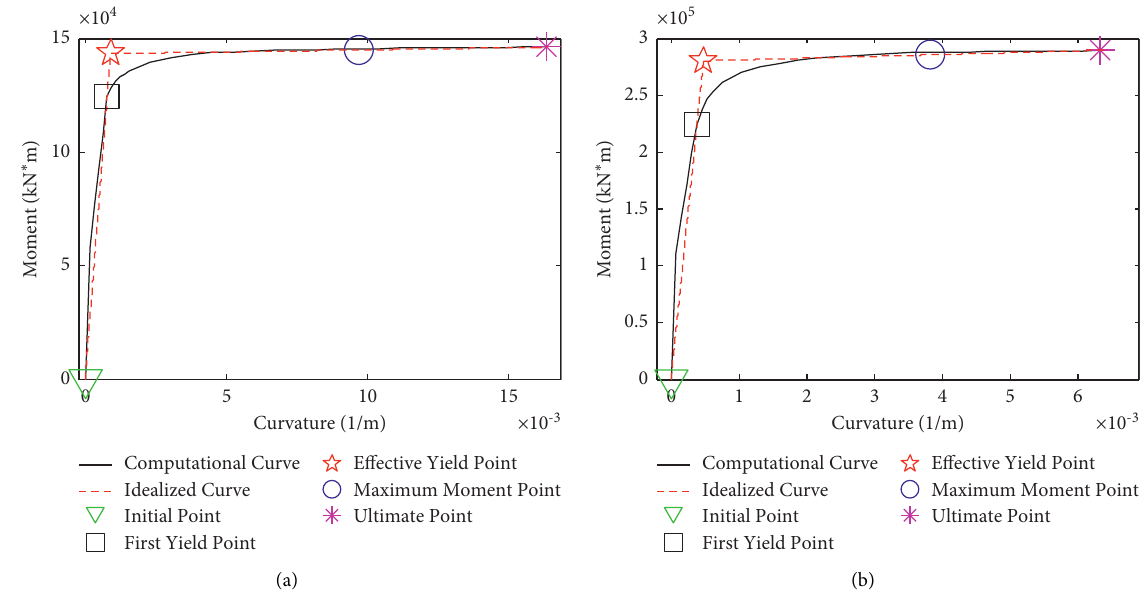
Figure 6: Moment-curvature relationships of middle pier bottom section (bridge completion stage). (a) Longitudinal moment-curvature relationships. (b) Transversal moment-curvature relationships. Table 4: Damage evaluation indexes boundary values of the middle pier bottom (bridge completion stage).